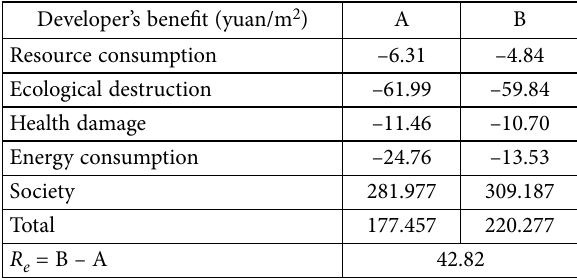
Table 4. Developer’s benefits for the two kinds of